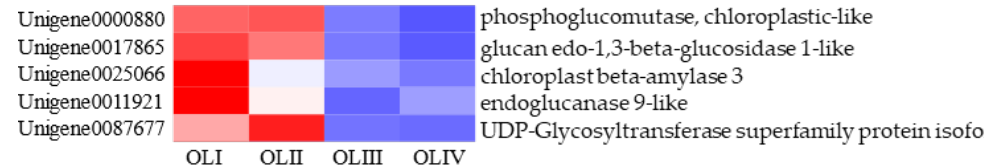
Figure 7. The heatmap showed the DEGs associated with starch and sucrose metabolism.